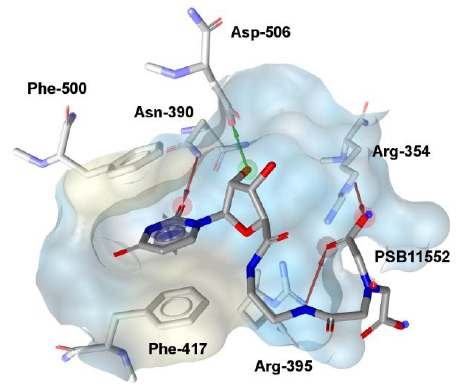
Figure 1. Pharmacophore model generated for PSB11552 complexed with human ecto -5 ′ -NT, using LigandScout [51]. Green sphere: hydrogen-bond donor; red spheres: hydrogen-bond acceptors; blue circles: aromatic ring. The surface corresponding to PSB11552 binding site is colored according to lipophilic potential, ranging from white (highest lipophilic area surface) to cyan (highest hydrophilic area surface).